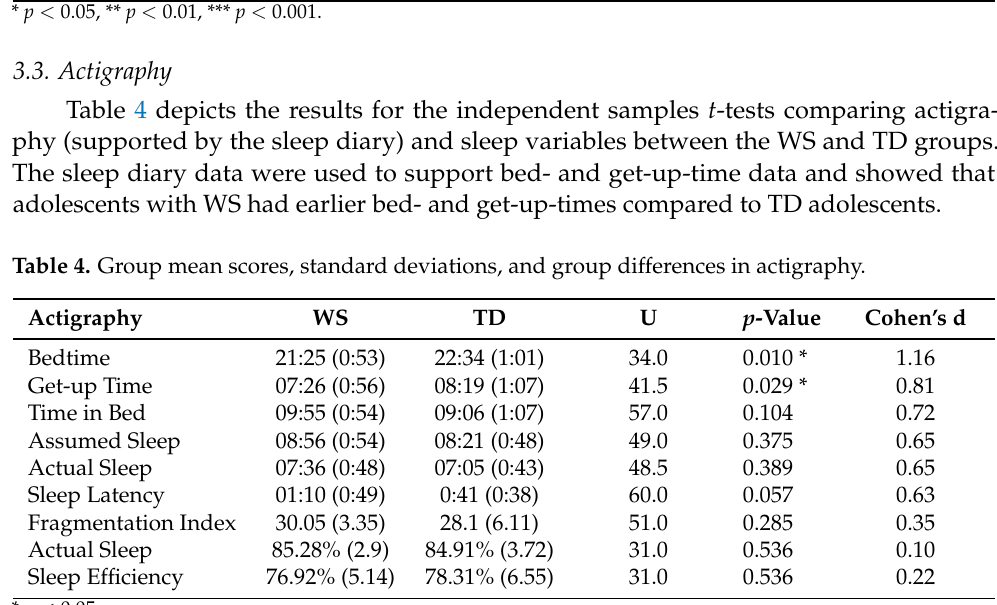
Obsessive Compulsive